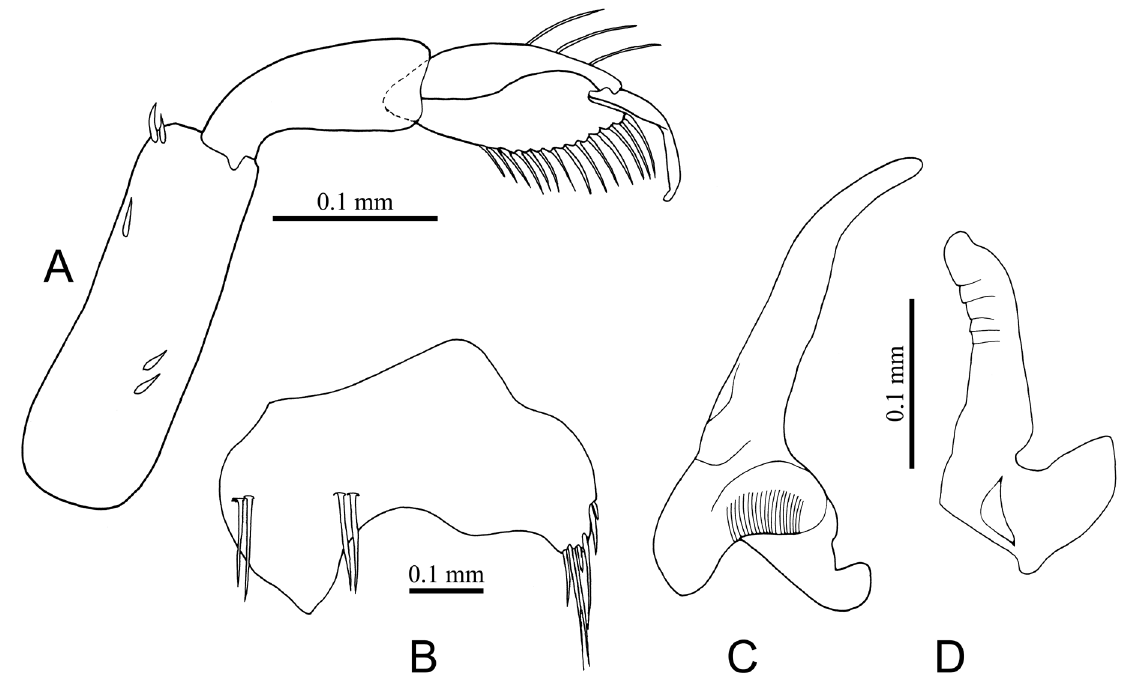
Fig. 24. Morphological features of Micronecta caperata sp. nov., ♂, paratype (ZVNU). A . Fore leg. B . sternite VII and median lobe. C . Right paramere. D . Left